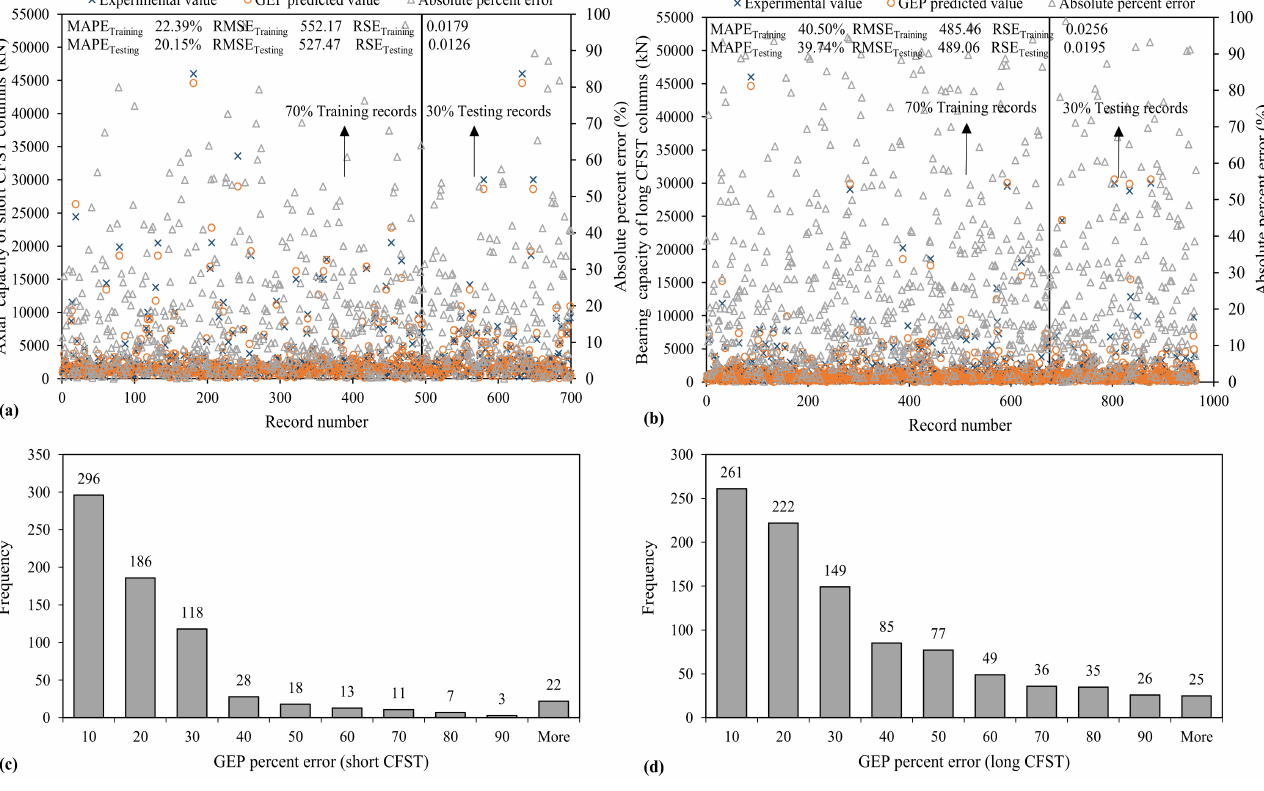
Figure 9. Variation of mean absolute error and error histograms of bearing capacity established using GEP algorithm ( a , c ) short CFST ( b , d ) long CFST columns. Table 4. Assessment of GEP model using external testing criterion suggested in the